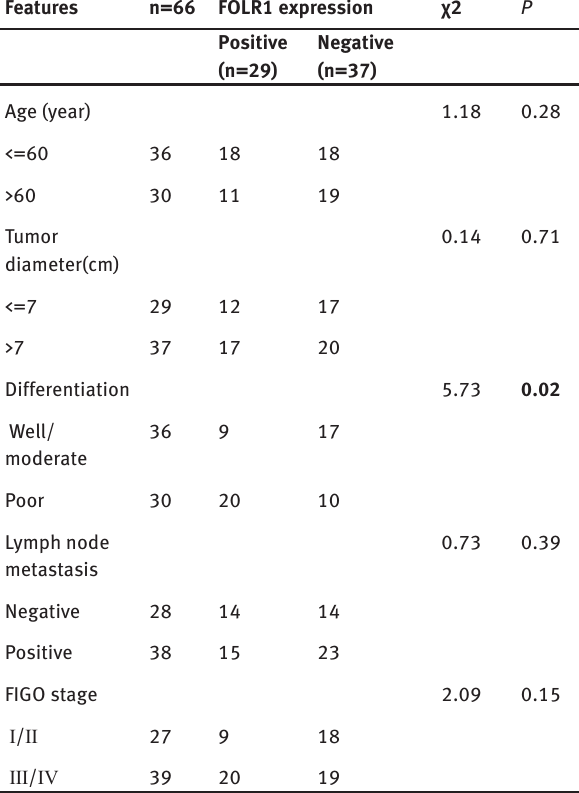
Table 4: FOLR1 protein expression and clinical pathological features of ovarian cancer